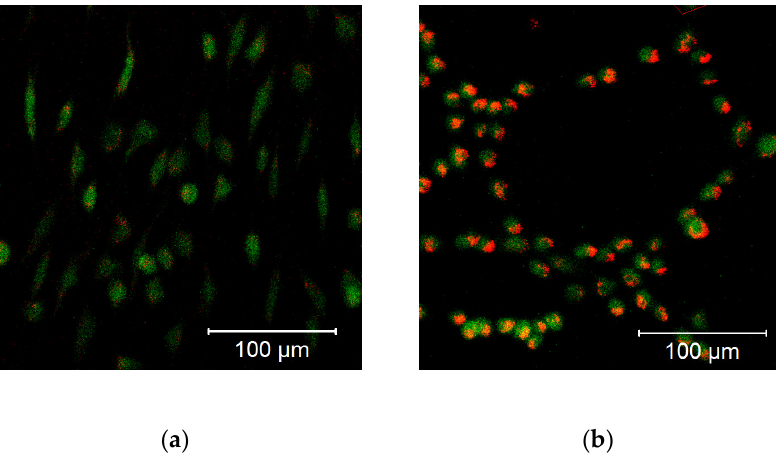
Figure 13. Morphological changes of the hBMSCs (passage 3) in response to the 10 µ M DPI 24-h treatment, mitochondrial membrane potential-sensitive TMRM probe, and cellular ROS-sensitive H2DCFDA probe. ( a ) Control group treated with 0.5% vol. DMSO. ( b ) Group treated with 10 µ M DPI. The images were taken with a Zeiss LSM 510 microscope, 10 × objective, 50 nM TMRM (red signal) or 10 µM (green signal) H2DCFDA probe concentration.